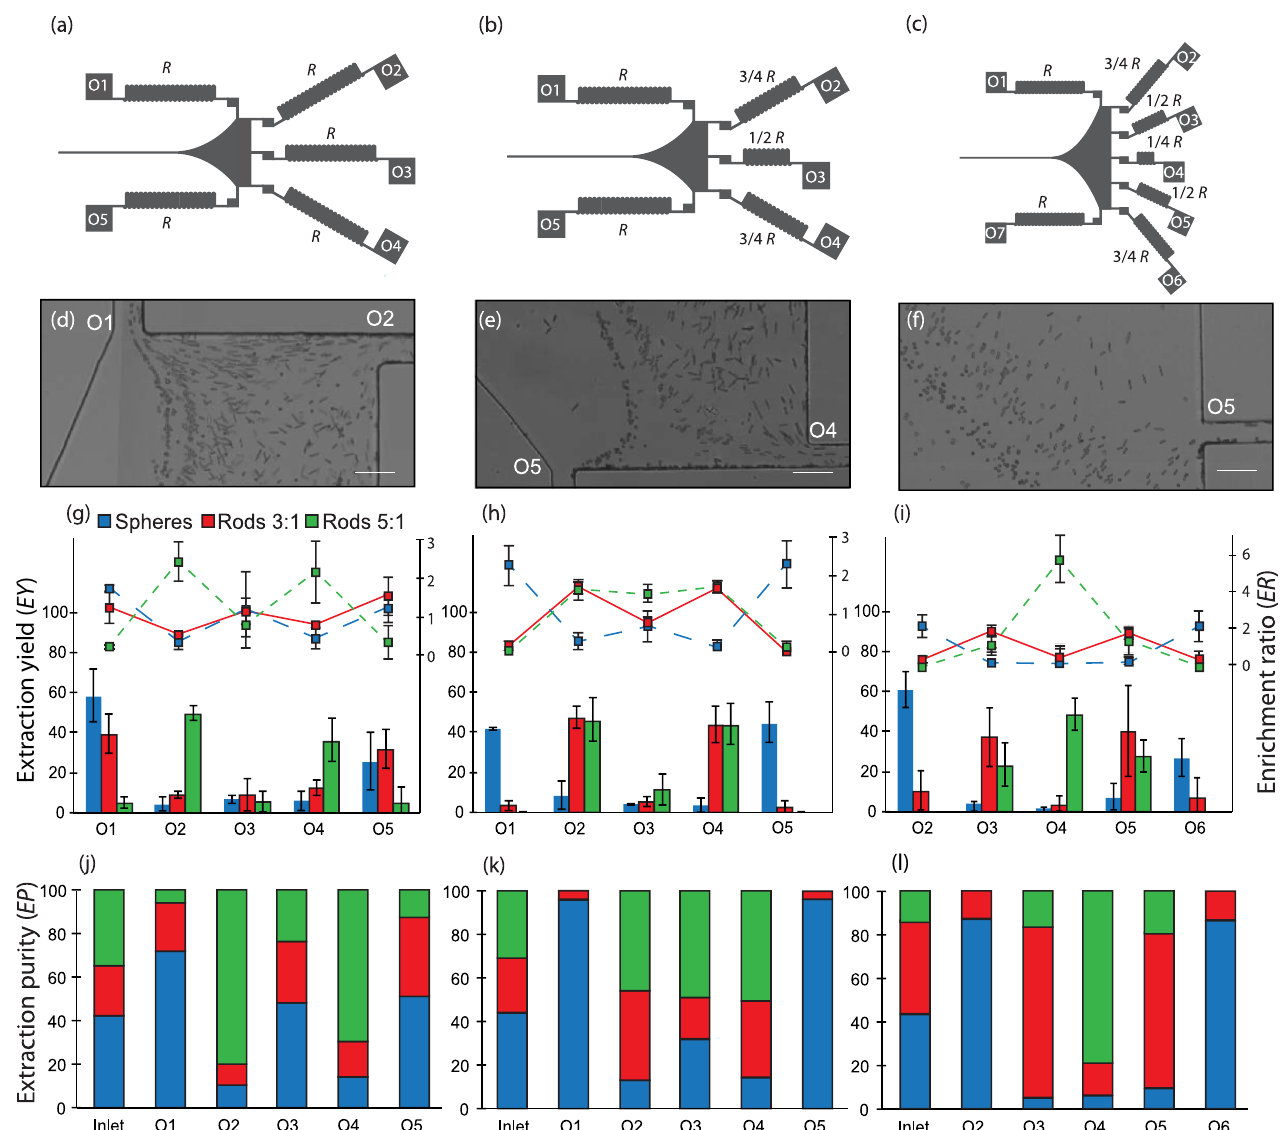
FIG. 5. Separation results for 6 - (cid:1) m spherical and ellipsoid particles. The collected ratio of particles is shown at each outlet, considering the extraction yield EY and the enrichment ratio ER (g),(h),(i), and the extraction purity EP (j),(k),(l). Each value shows the mean (cid:4) SD from three independent experiments. Three configurations of the SAPS device are considered (a),(b),(c), and stacked ¼ 0 : 53 , Q ¼ 40 (cid:1) L = min , five pictures of the separation are shown for each configuration (d),(e),(f). Scale bar: 50 (cid:1) m . (a) AR c ¼ 0 : 64 , Q ¼ 80 (cid:1) L = min , five outlets (O1 to O5) with (cid:5) ¼ 3 = 4 and (cid:5) ¼ 1 = 2 ; outlets with equal resistances (R); (b) AR c 1:2 1:3 ¼ 0 : 64 , Q ¼ 70 (cid:1) L = min , seven outlets (O1 to O7) with (cid:5) ¼ 3 = 4 , (cid:5) ¼ 1 = 2 , (cid:5) ¼ 1 = 4 . In (i) and (l), since no particles (c) AR c 1:2 1:3 1:4 were captured from outlets O1 and O7, only the collected ratio of particles at outlets O2 to O6 appear in the